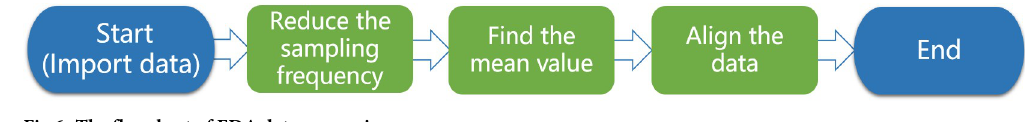
Fig 6. The flowchart of EDA data